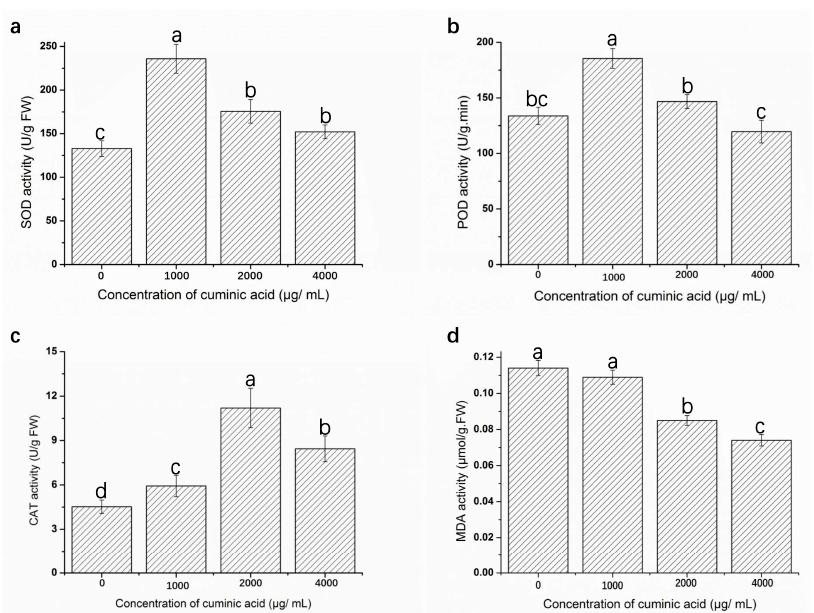
Figure 5. SOD ( a ); POD ( b ) and CAT ( c ) activities and MDA activity ( d ) of the watermelon leaves treated with cuminic acid at 0, 1000, 2000 and 3000 μ g/mL, respectively. Data represents means of three replications with standard deviation. Data (means ± SD, n = 3) followed by the same letters in the row show no significant differences (small letters, p < 0.05).